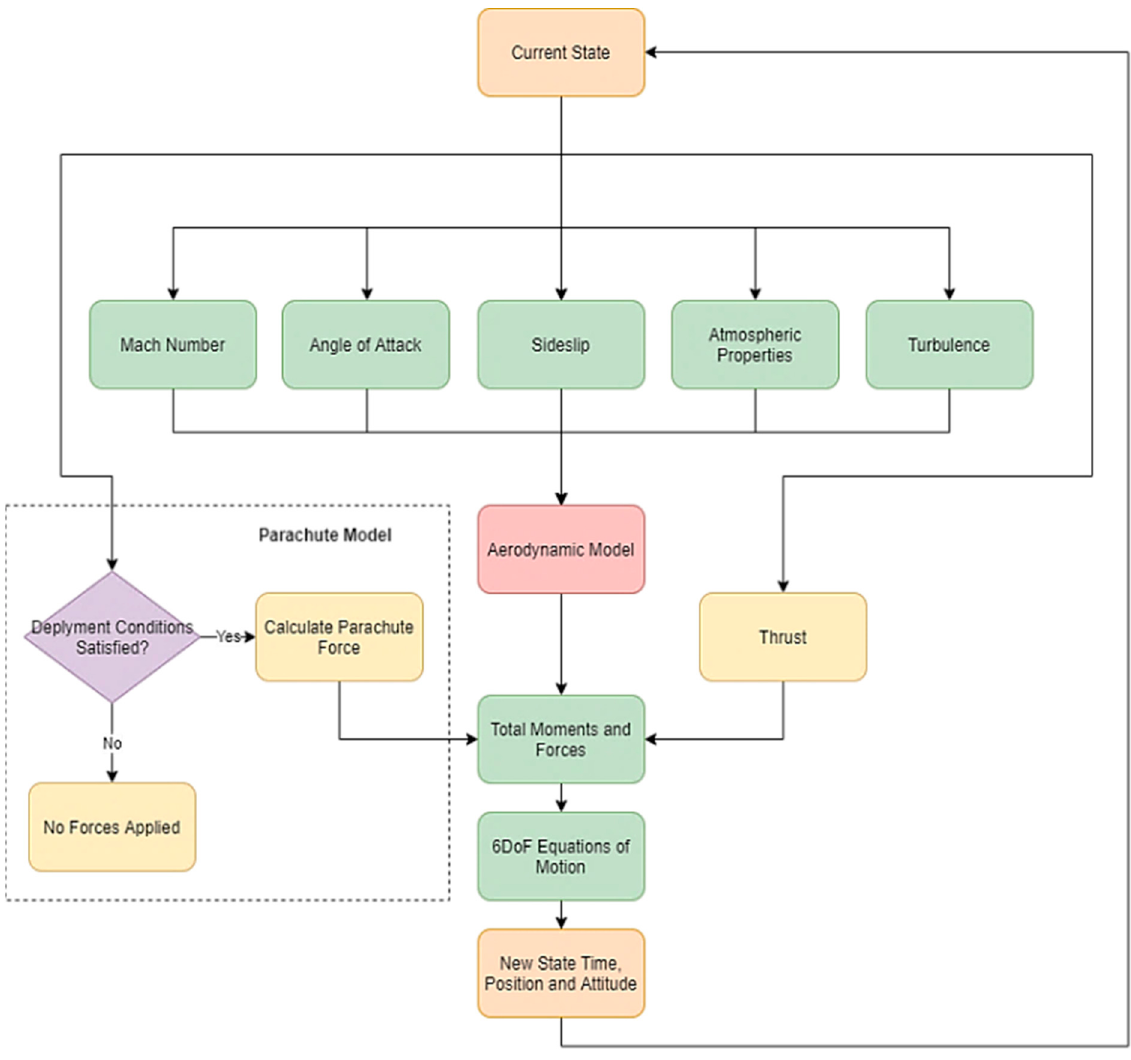
Figure 2. Flowchart of the overall model determination process.